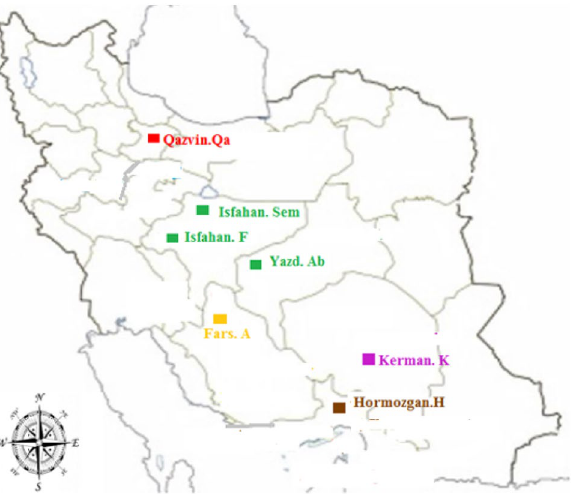
Figure 3. Sites of collection of Moshgak population from different geographical regions of Iran, used in this study. The population gene bank number are shown in Table